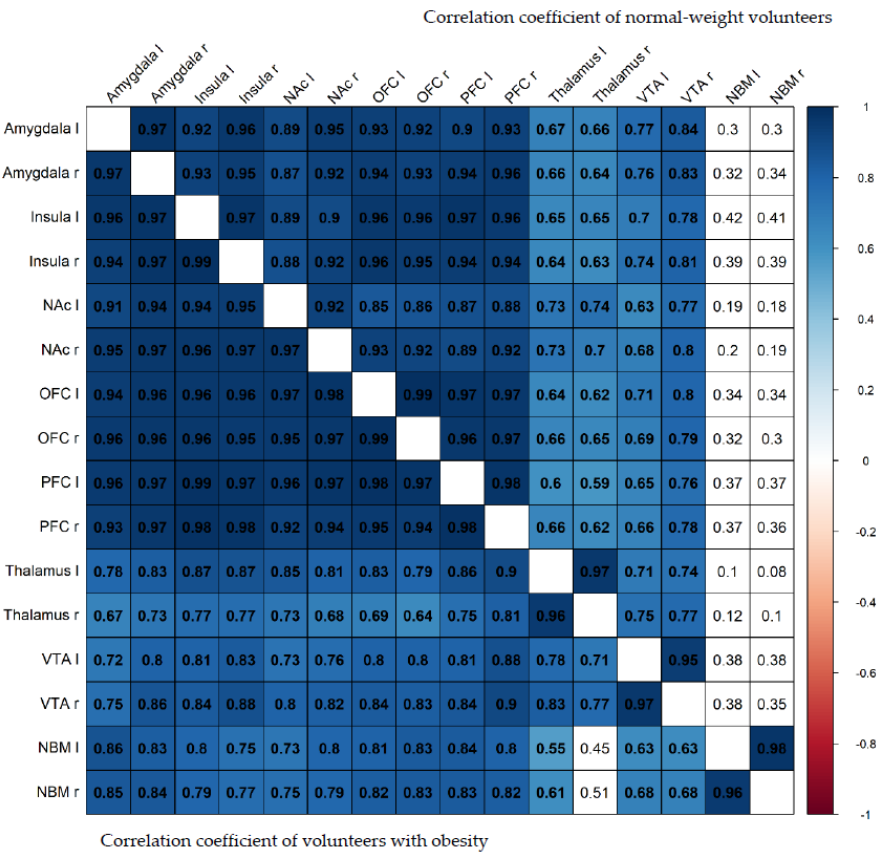
Figure 4. The ( ‐ ) ‐ [ 18 F]flubatine average total distribution volume of all normal ‐ weight volunteers (first row) and volunteers with obesity (second row) using positron emission tomography co-registered to T1 (third row) magnetic resonance imaging.